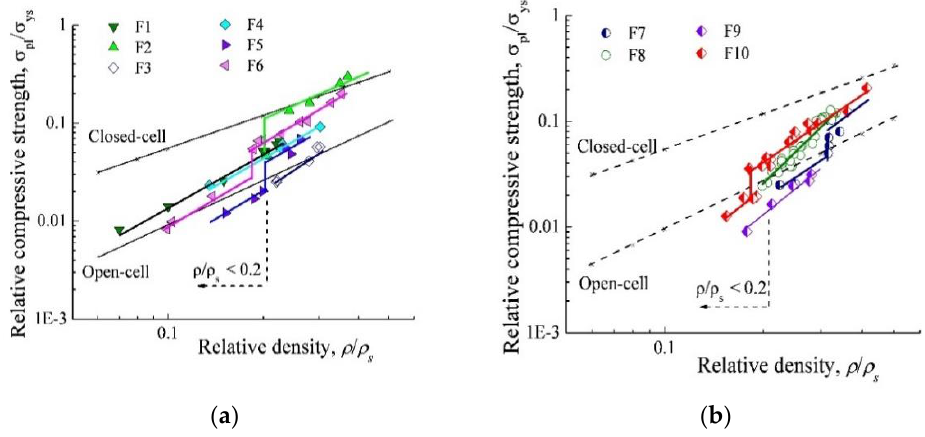
Figure 2. Relative compressive strength, σ pl / σ ys , dependences on the relative density, ρ / ρ s , for the foams produced with TiH 2 (F1, F3, F5, F7, F9) and CaCO 3 (F2, F4, F6, F8, F10), which are performed with various parent alloys: ( a ) Al (F1, F2), Al-Si, (F3, F4), Al-Mg-Si (F5, F6) and ( b ) Al-Zn-Mg (Sc,Zr) (F7, F8), Al-Zn-Mg (F9, F10).